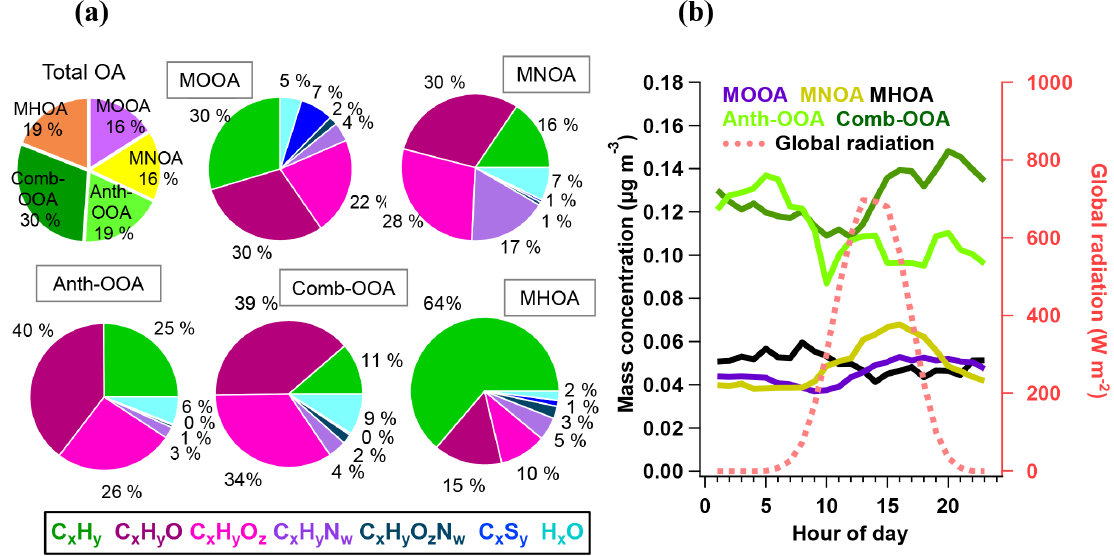
Figure 4. (a) Average mass fraction of each component in the total OA mass concentration, the functional group composition of each OA factor and (b) diurnal variations of five OA factors with global